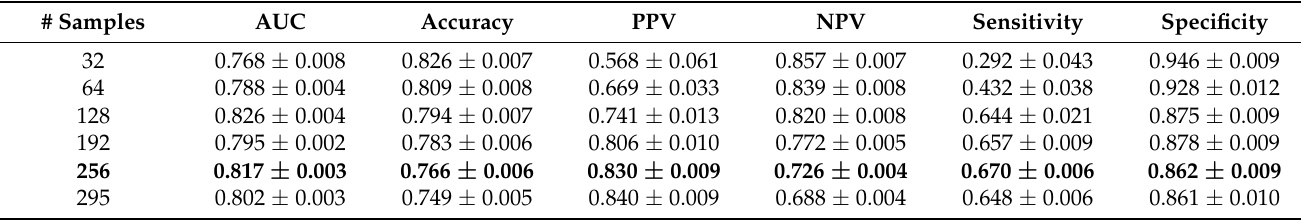
Table 3. Results for the benign vs. malignant primary nodule classification (Aim 2) achieved by the nested 5-fold CV on the discovery set for the Borderline-SMOTE over-sampling method. The metrics are expressed as average ± standard deviation. The rows in boldface denote the best performing configuration according to sensitivity and PPV.